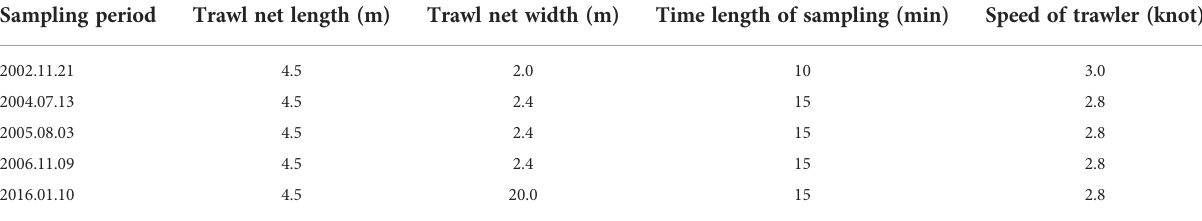
TABLE 1 Parameters of trawl net used during sampling period.